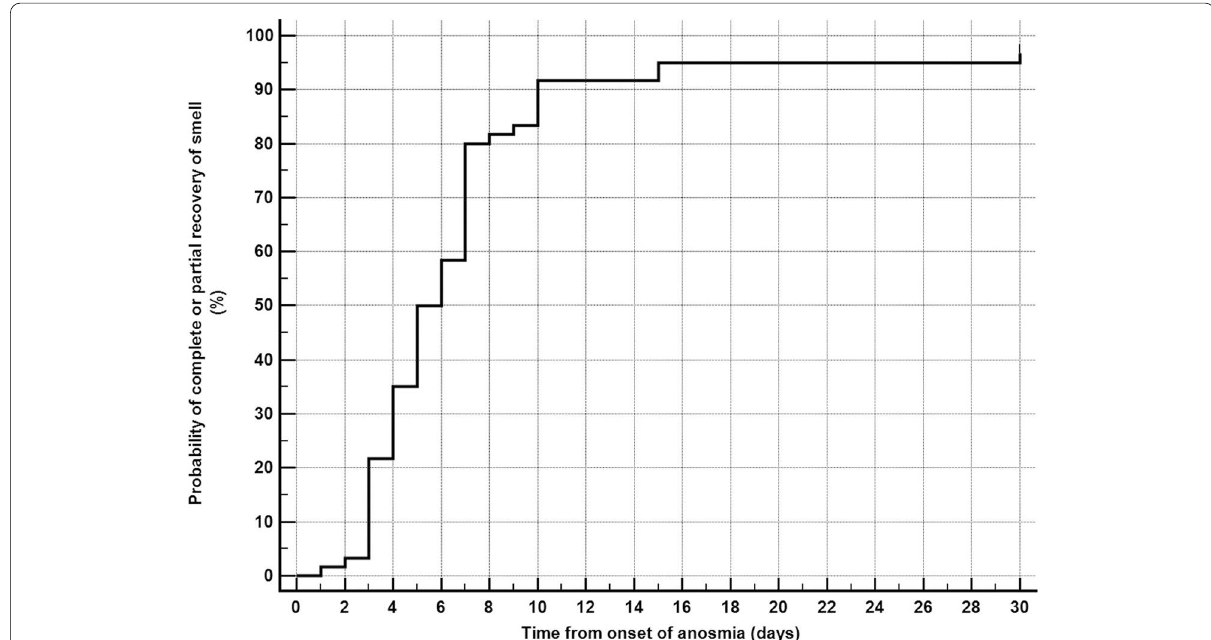
Fig. 2 Kaplan-Meier curve for time to complete or partial recovery of smell. Median time to complete or partial recovery days)